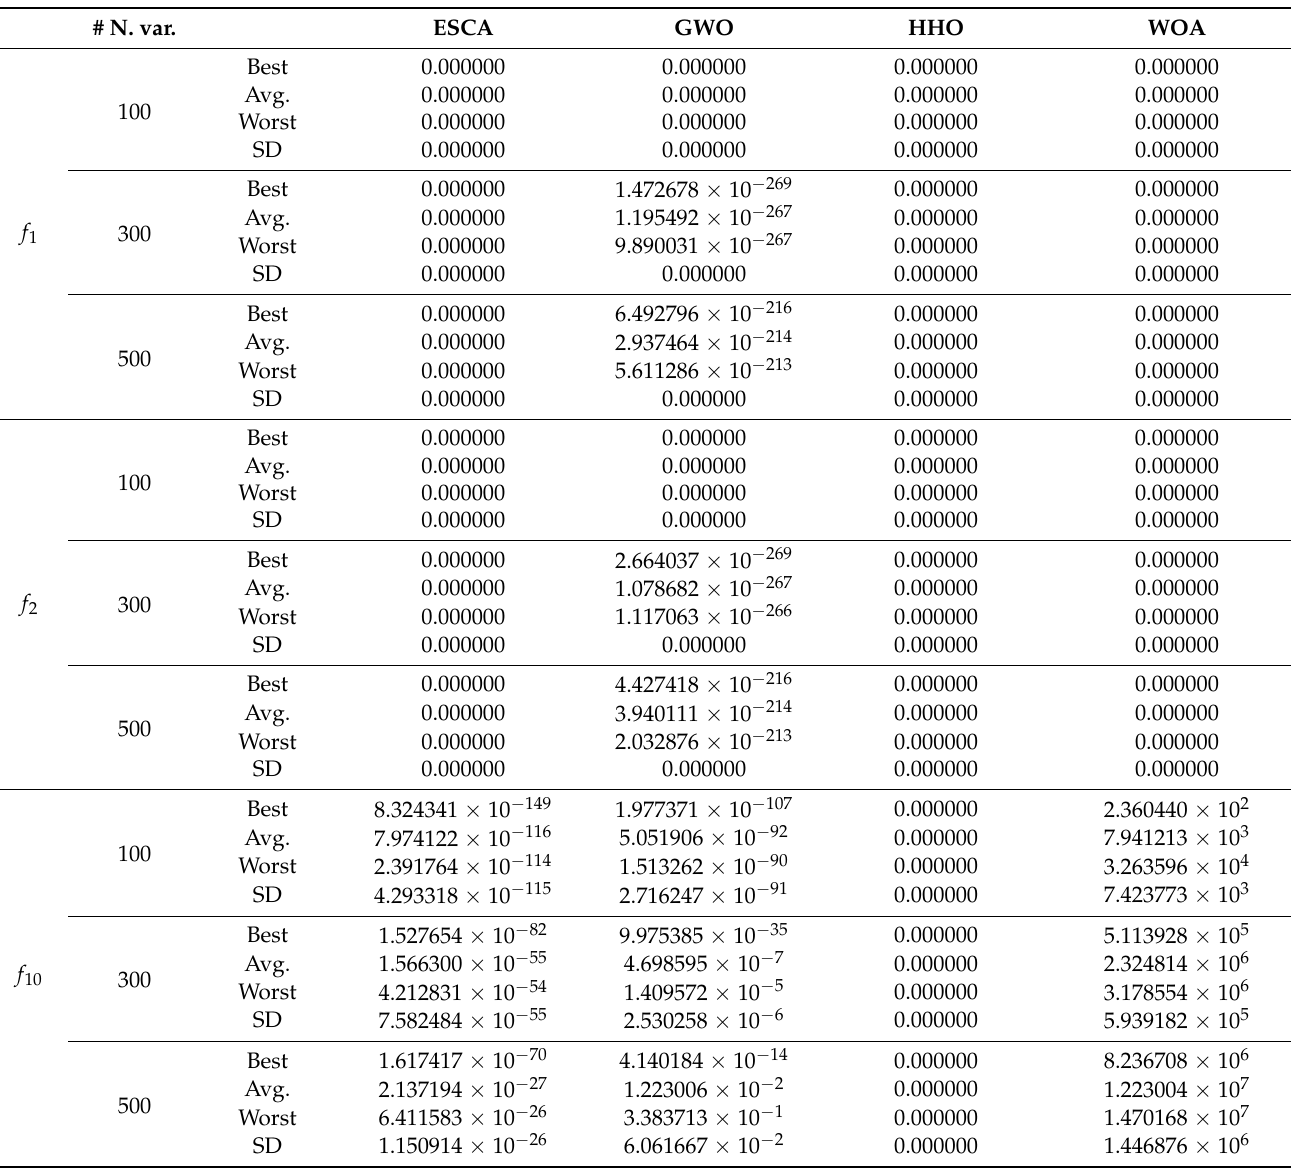
Table 23. Statistical data for 30 runs with a population of 120 and 10,000 iterations for high-dimensional